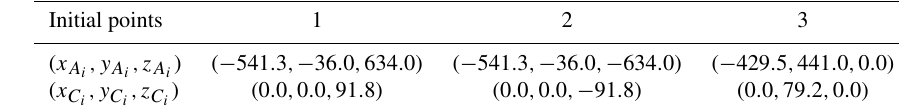
Table 1. Coordinates of the initial points C i ( i = 1 , 2 , 3) and A i ( i = 1 , 2 , 3).